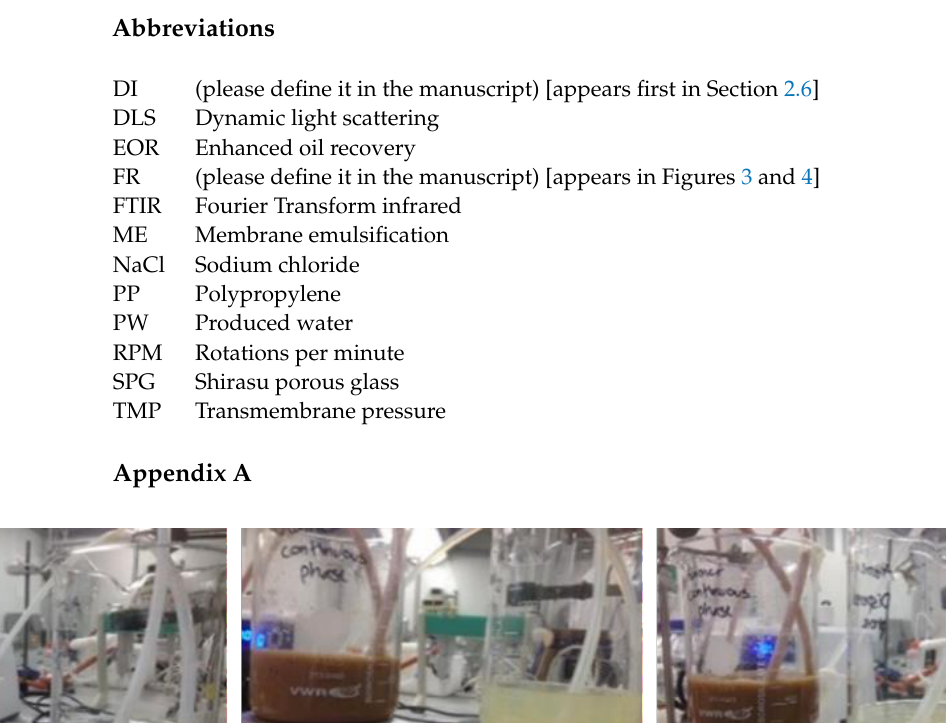
Figure A1. Emulsion formation as function of experimental time (from 0–3.5 h) for the experiments carried out at 0.25 bar pressure.